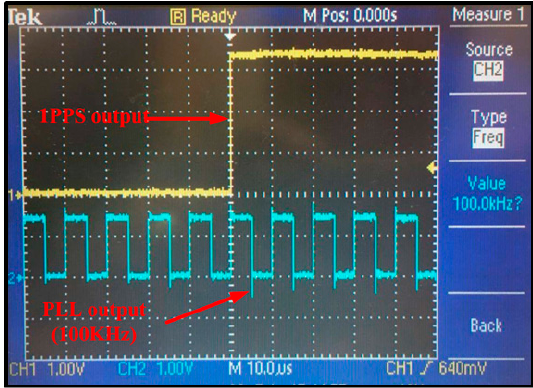
Figure 18 . 1PPS and high-frequency output signal.